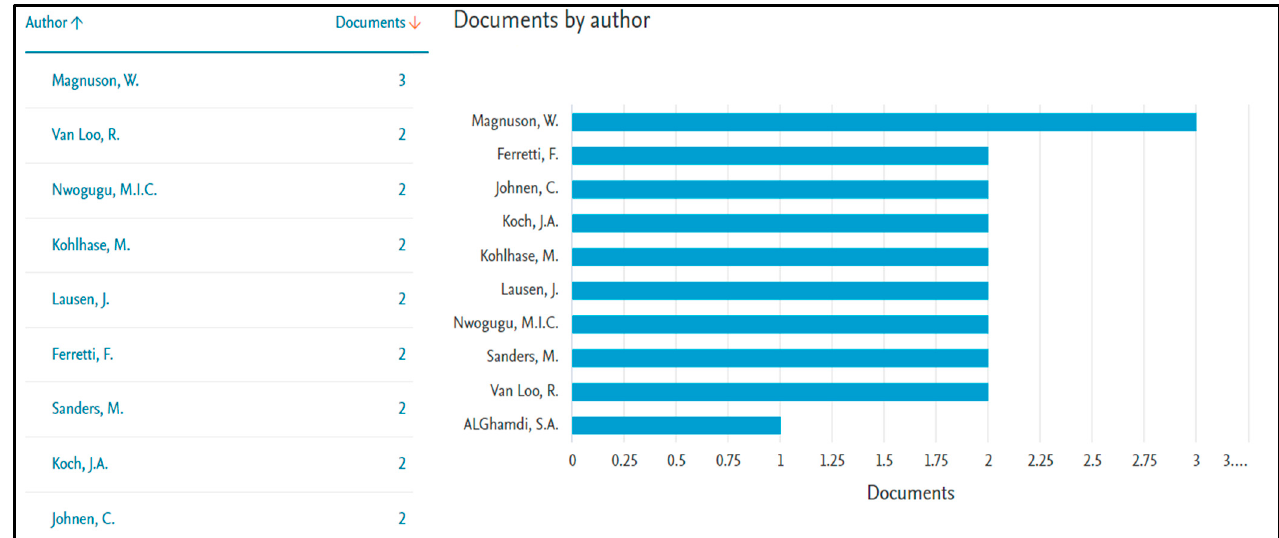
Figure 2. Document production by author.